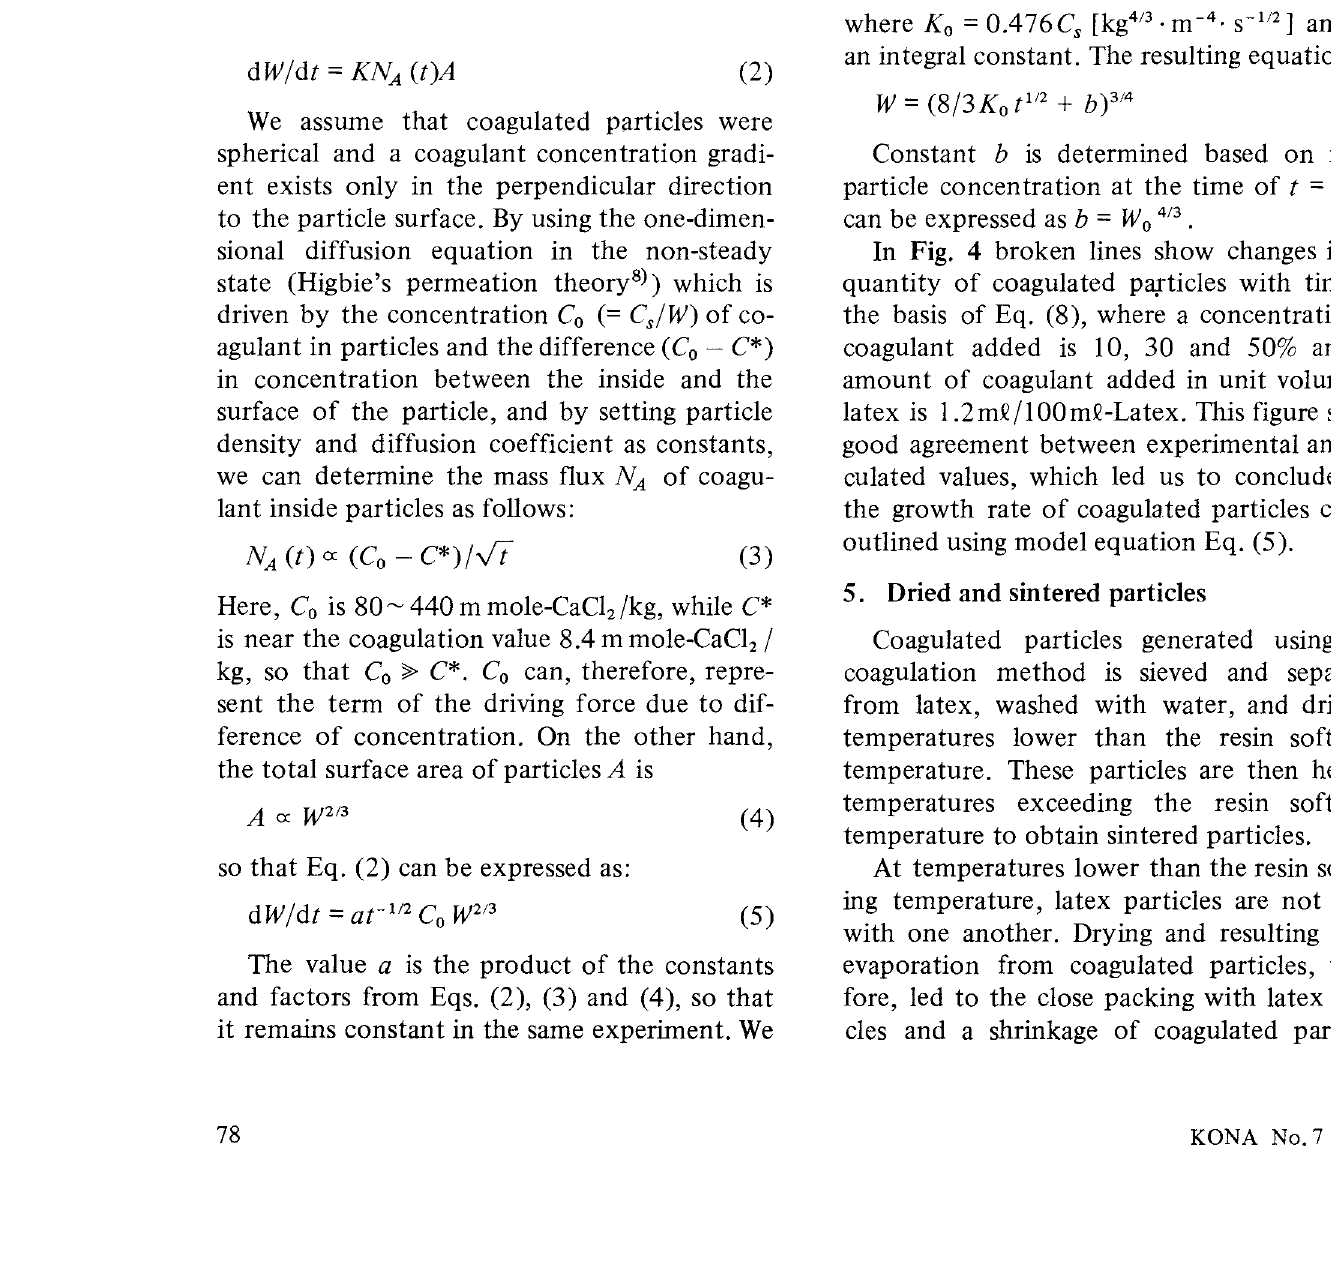
Fig. 5 Correlation for the effect of operational function in Eq. (5) on the growing rate of